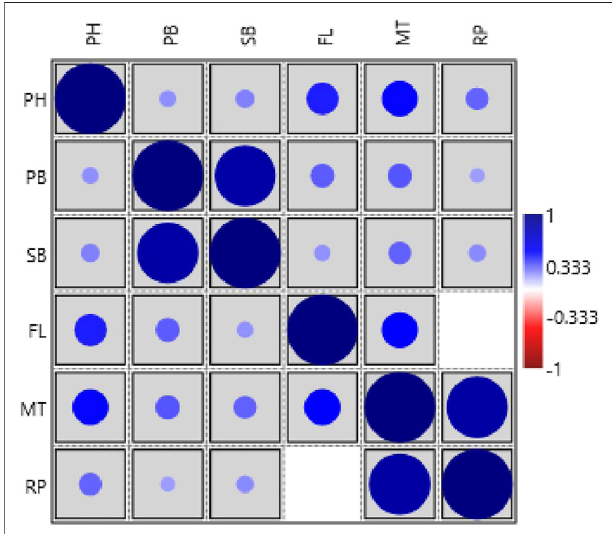
FIGURE 3 | Pearson ’ s correlation matrix among different traits analyzed intheHPM249HPK4RILs(PH-Plantheight,PB-No.ofprimarybranches,SB- No. of secondary branches, FL-Days to 50% fl owering, MT- Days to maturity, RP- Reproductive period).